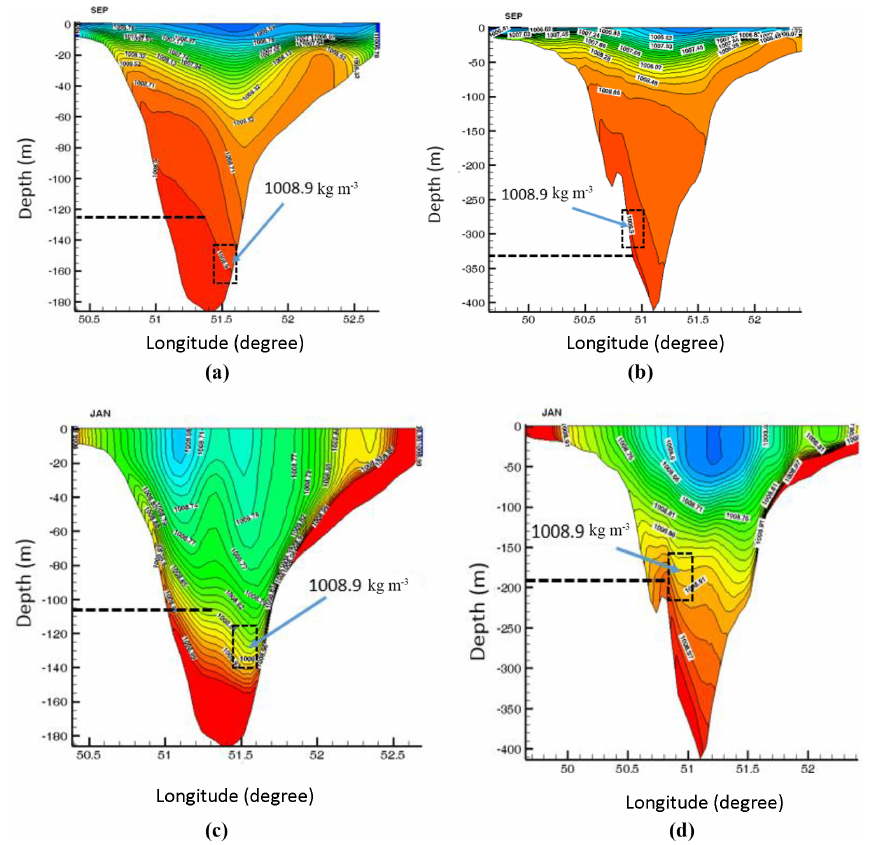
Figure 10. Simulated density fields along transects I (a, c) and II (b, d) in September (a, b) and January (c, d) 2004. The reference isopycnal of the deep flow boundary is also